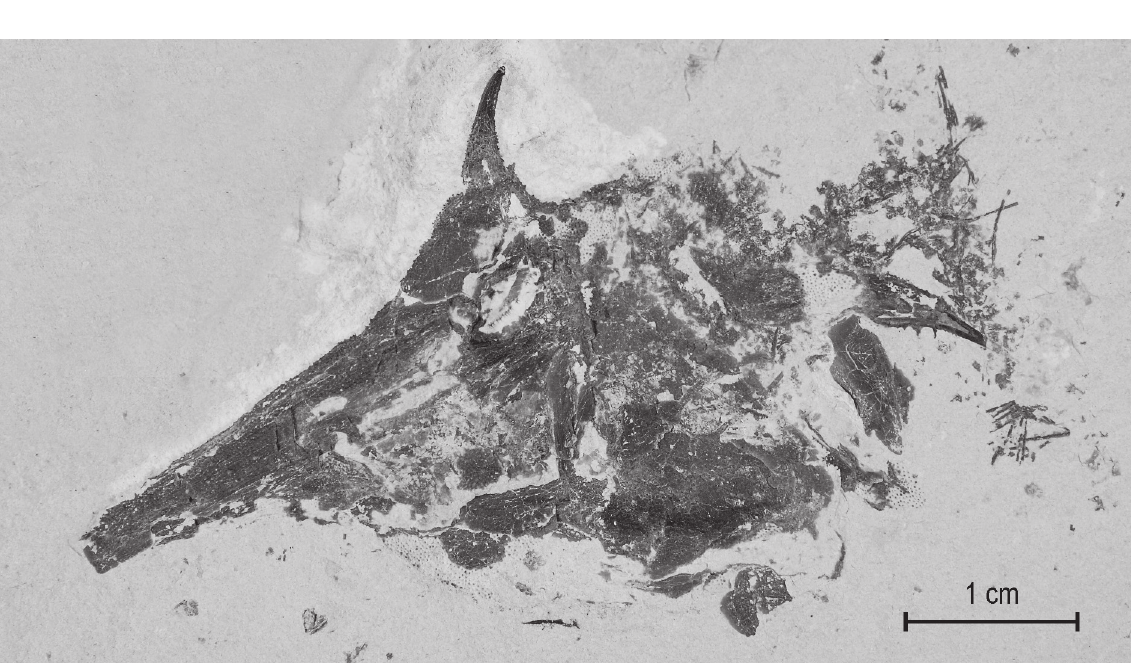
Fig. 16. Rostropycnodus gayeti gen. et sp. nov. Paratype CLC S-337.